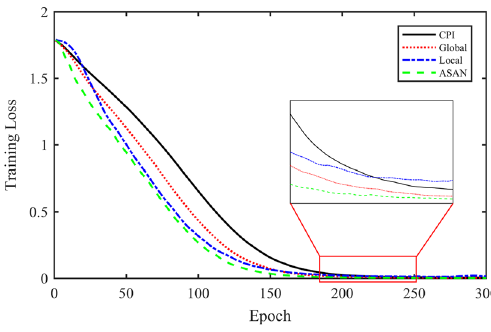
Figure 18. Training loss curves under different models.